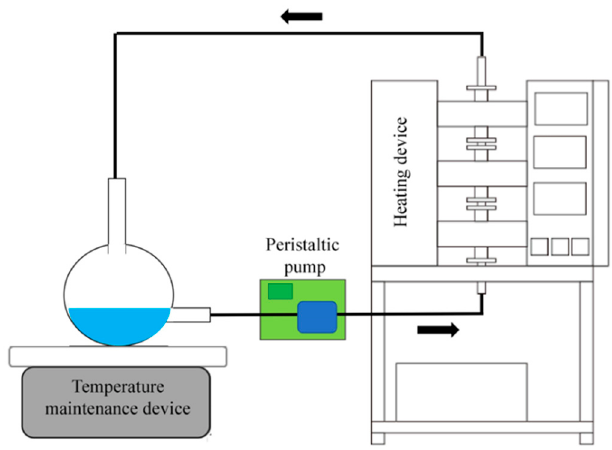
Figure 1. Atmospheric pressure microwave reflux device for Zn-saponite synthesis.